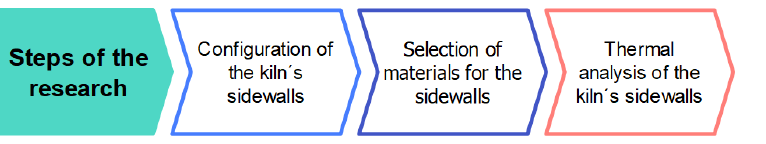
Figure 1. Sequence for the thermal analysis of configurations and sidewalls materials of the kiln.